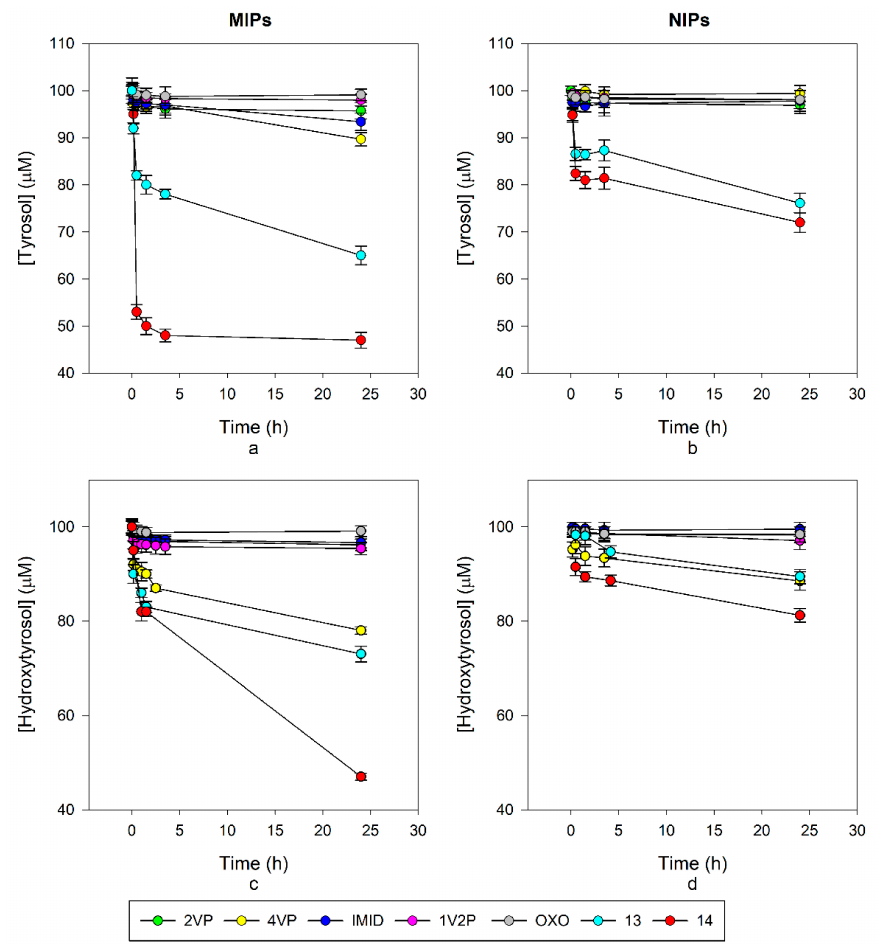
Figure 4. ( a ) Decay of TY concentration in 100 µ M solutions upon incubation with the MIPs; ( b ) decay of TY concentration in 100 µ M solutions upon incubation with the NIPs; ( c ) decay of HT concentration in 100 µ M solutions upon incubation with the MIPs; ( d ) Decay of HT concentration in 100 µ M solutions upon incubation with the NIPs.